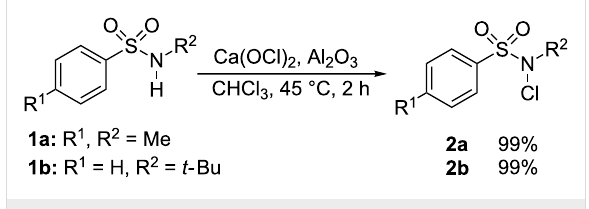
Scheme 1: Preparation of the